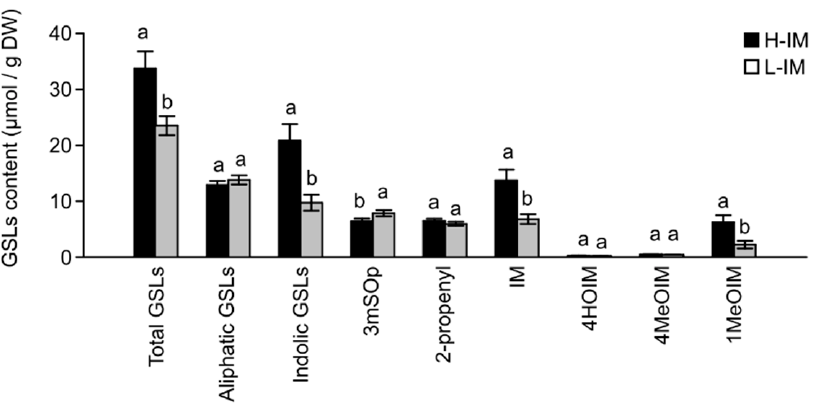
Figure 2. Glucosinolates content in two populations of kale from divergently selected populations with varied indol-3-ylmethylGSL (IM) content (H-IM: High IM content; L-IM: Low IM content). Error bars represent ± standard error (SE). Within each glucosinolate category different letters indicate significant differences between divergent populations (ANOVA, p -value ≤ 0.05). Complete ANOVA table results is presented as Supplementary Material (Table S2). Abbreviations: GSLs: Glucosinolates, 3mSOp: 3-(methylsulfinyl)propylGSLs, 2-propenyl: 2-propenylGSL, IM: indol-3-ylmethylGSL, 4HOIM: 4-hydroxyindol-3-ylmethylGSL, 4MeOIM: 4-methoxyindol-3-ylmethylGSL and 1MeOIM: 1-methoxyindol-3-ylmethylGSL.